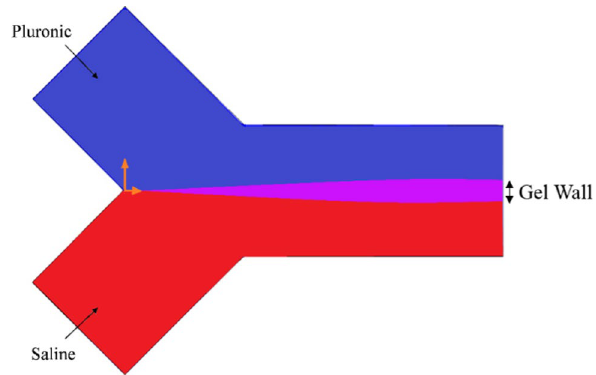
Fig. 1 Schematic of the Y-shaped microchannel used in this